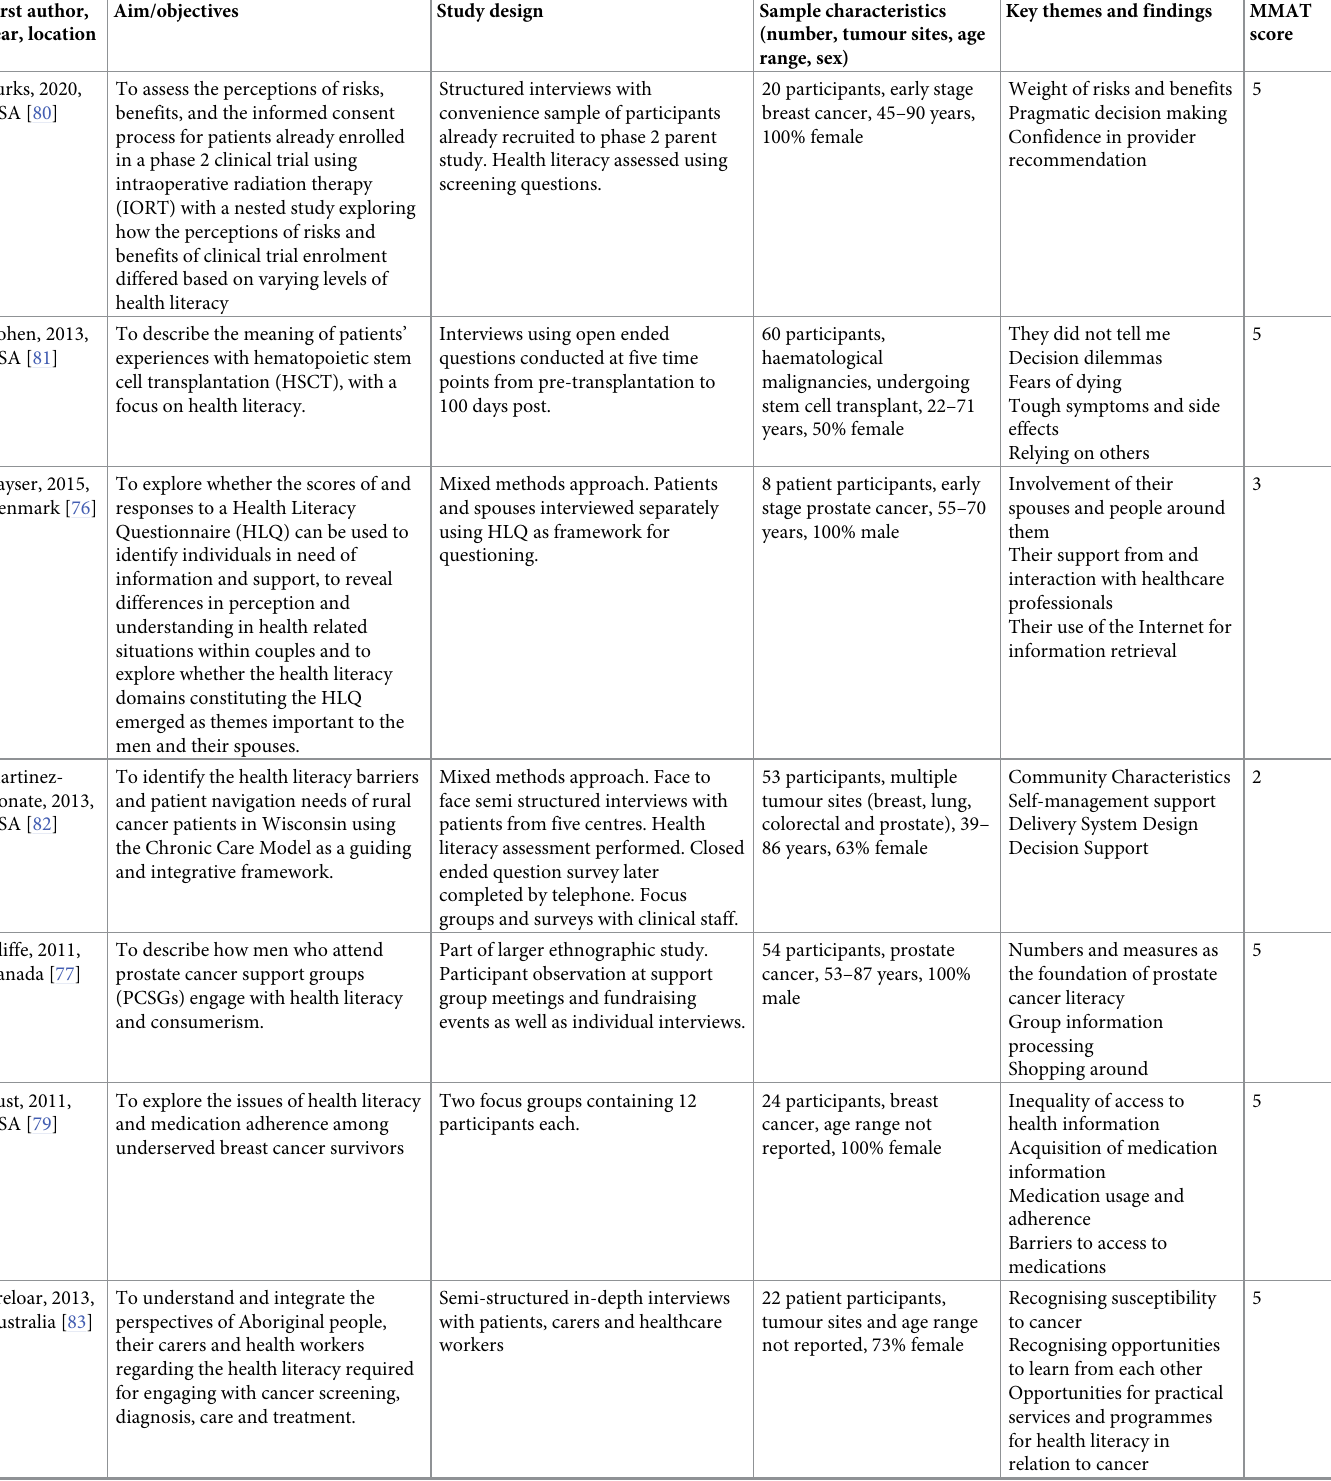
Table 3. Qualitative studies exploring the role of health literacy in patients to access, understand, appraise and use information and services to make decisions about